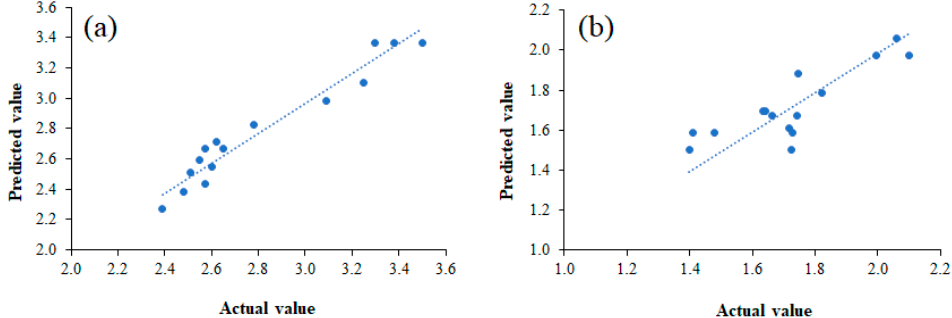
Figure 2. The correlation plots of actual and predicted values of the extraction yield ( a ) and peroxide value ( b ).